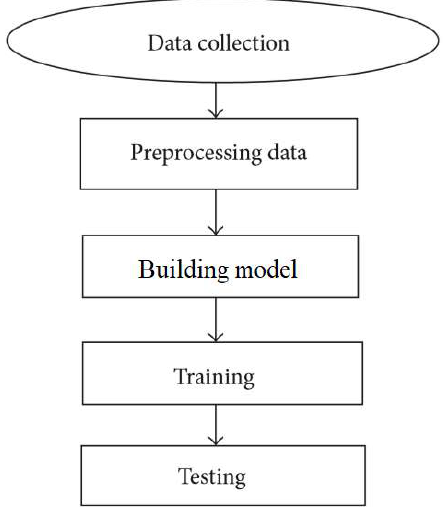
Figure 2. Basic flow for building the machine learning (ML) model.